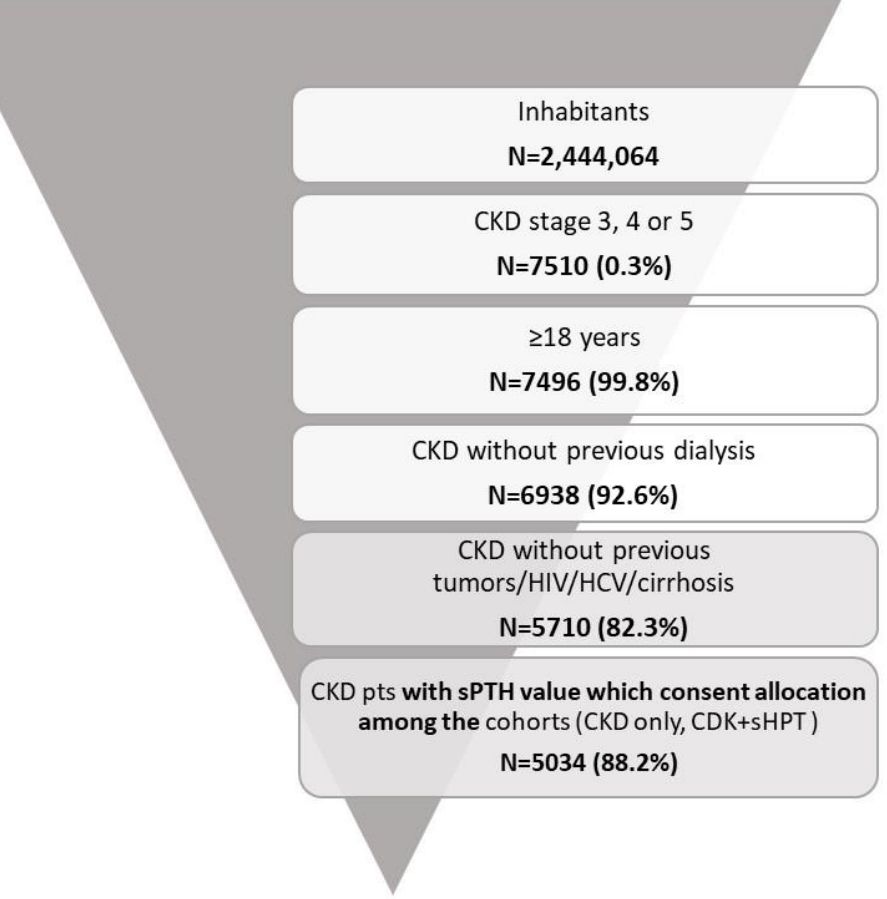
Figure 1. Flow-chart for the definition of cohorts included in the analysis.